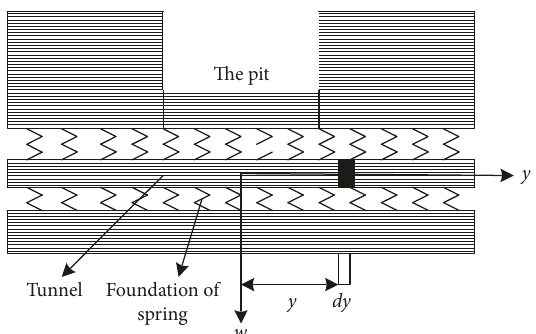
Figure 5: Double-sided elastic foundation beam model.